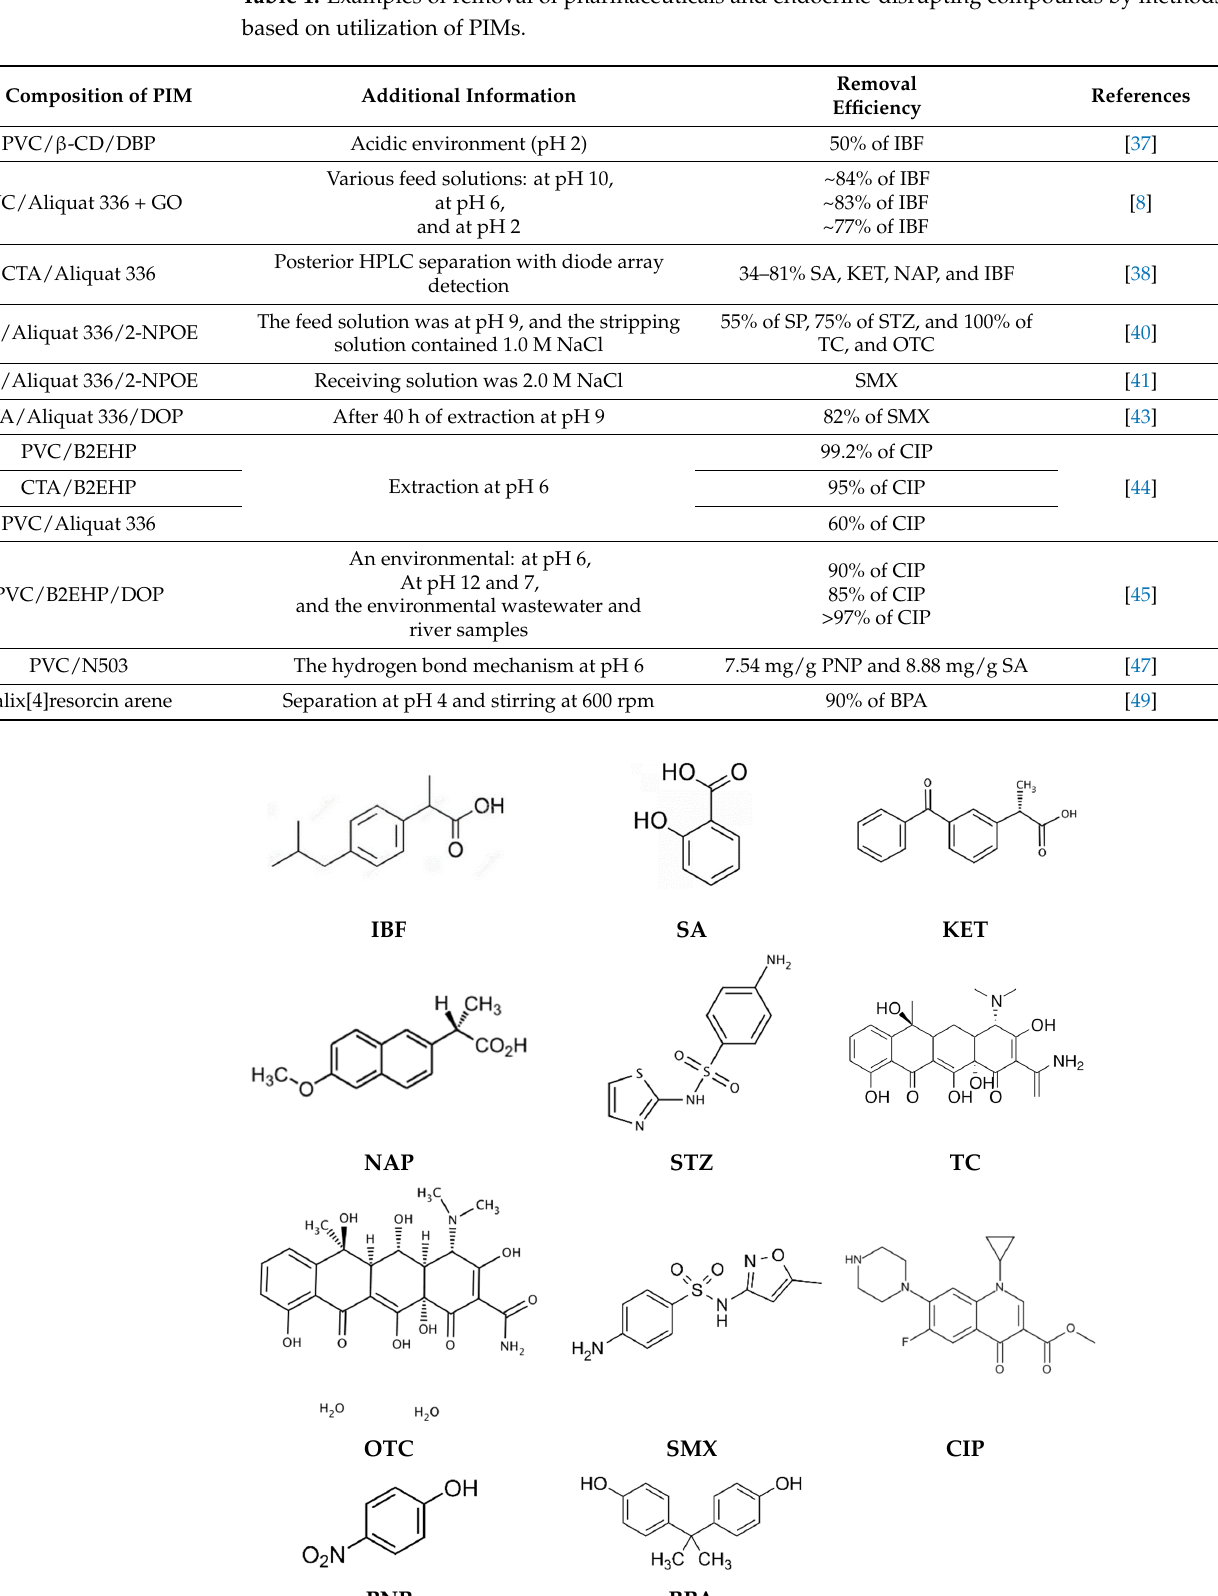
Figure 1. Structures of pharmaceuticals and endocrine ‐ disrupting compounds removed by PIMs. Table 1. Examples of removal of pharmaceuticals and endocrine ‐ disrupting compounds by meth ‐ ods based on utilization of PIMs.